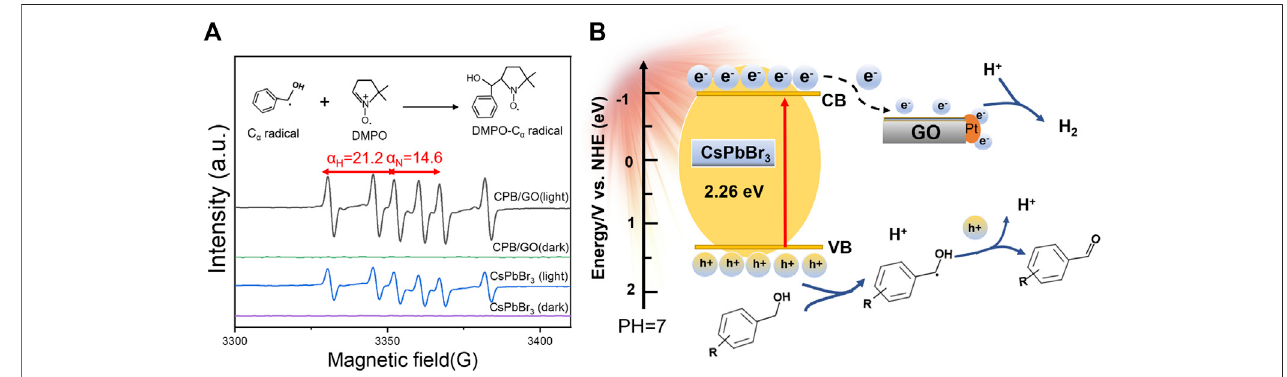
FIGURE 4 | (A) In situ EPR spectra of CsPbBr 3 and CPB/GO composites tested in Ar-saturated CH 3 CN solution in the presence of DMPO. (B) Schematic illustration of photocatalytic H 2 production integrated with aromatic aldehyde synthesis.